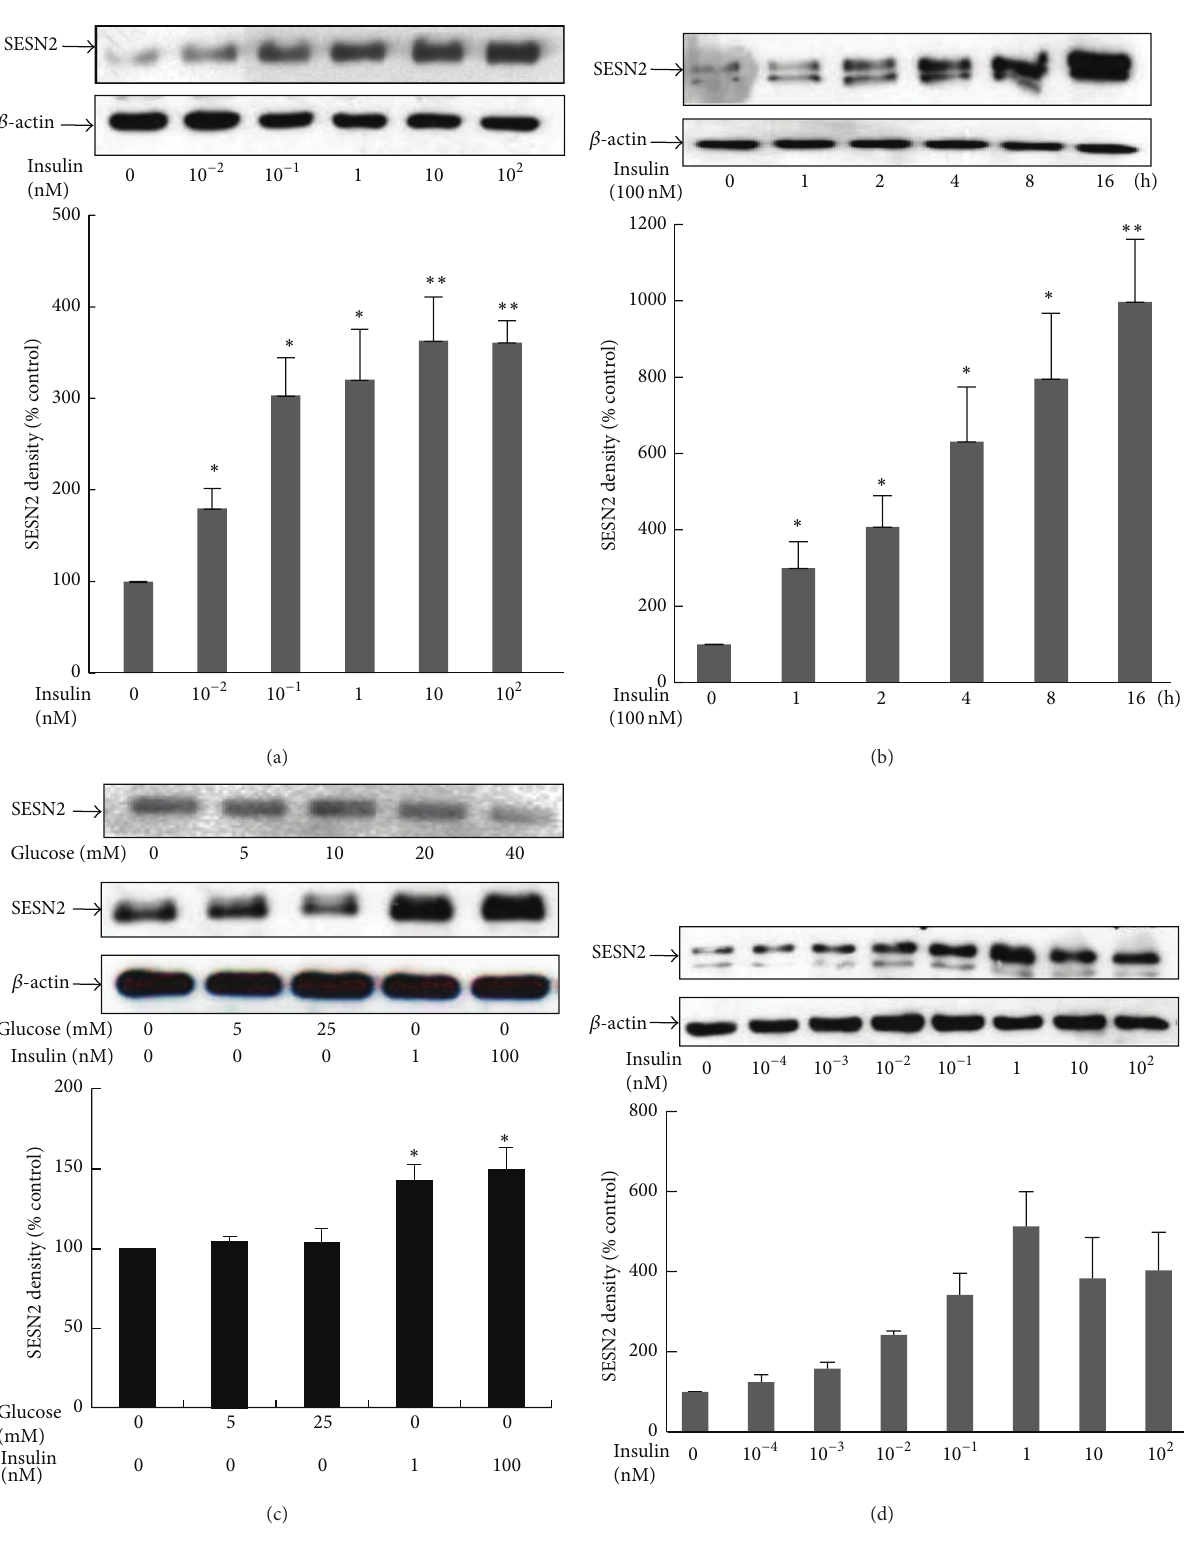
Figure 1: Insulin treatment upregulates SESN2 protein levels in hepatic cells. HepG2 cells were incubated with indicated concentrations of insulin for 18 h (a and c) or 100 nM insulin for indicated time course (b). Cells were harvested for western blotting. In (a) and (b), HepG2 cells were cultured in DMEM containing 25 mM glucose. In (c), cells were grown with the indicated concentrations of glucose. (d) Primary mouse hepatic cells were treated with the indicated concentrations of insulin for 18h, followed by cell harvesting and western blotting. Upper panels: western blot of SESN2 and 𝛽 -actin (loading control); lower panel: densitometric analysis of two independent experiments. ∗ 𝑃 < 0.05 ; ∗∗ 𝑃 < 0.01 compared with noninsulin